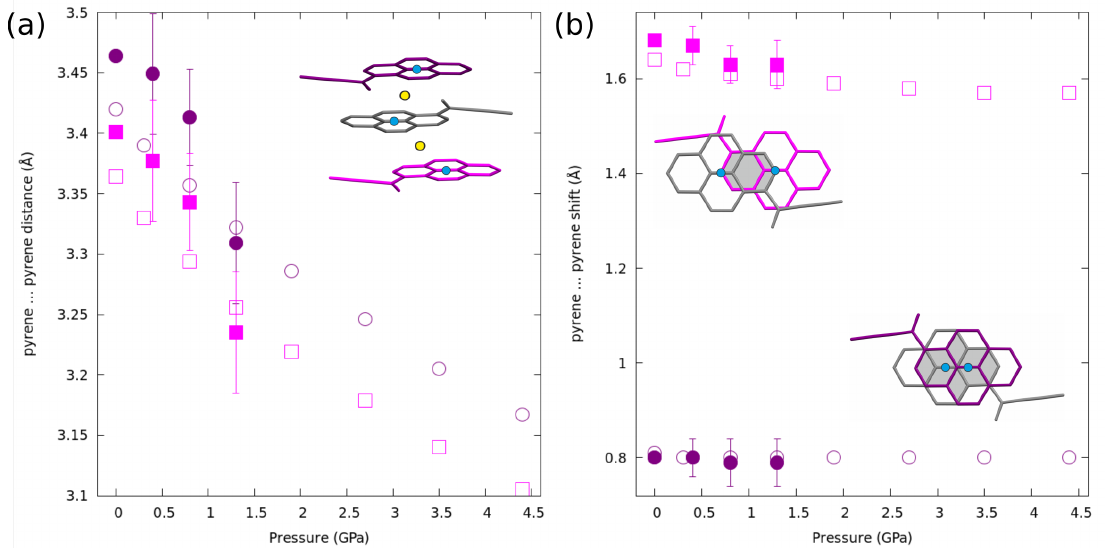
Figure 6. Variation of the ( a ) inter-planar distances in a π -stack with pressure; the purple-grey pair represents the “dimer” within the stack; ( b ) lateral shifts involving 1a molecules within a “dimer” (purple circles) and molecules from consecutive dimers (magenta squares) with pressure. The centers of each pyrene moiety represented as blue dots, crystallographic centers of symmetry—as yellow dots. Experimental results represented by filled markers with uncertainties, results of theoretical calculations by empty ones.